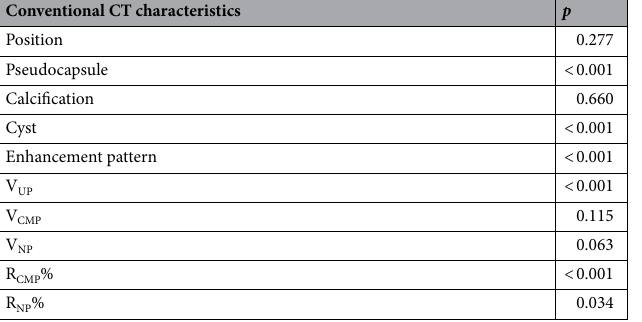
Table 1. Conventional CT analysis. The conventional qualitative CT characteristics including position, pseudocapsule, calcification, cyst, enhancement pattern were compared with the method of Pearson chi-square test. And the conventional quantitative CT characteristics including V UP , V CMP , V NP , R CMP %, and R NP % were compared with the method of independent-sample T-test. A p < 0.05 showed significant